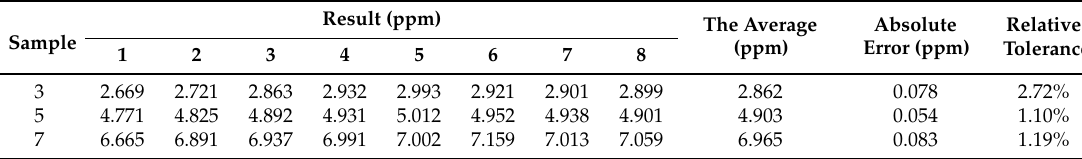
Table 2. Accuracy of the Measurements.